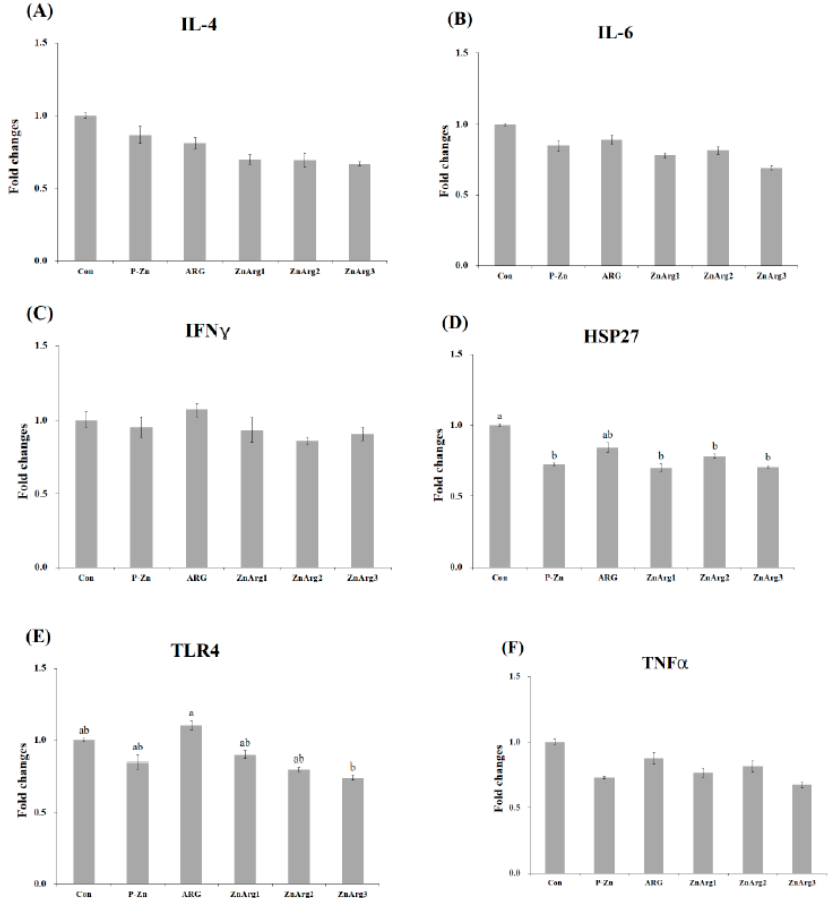
Figure 1. Relative expression of, ( A ) interleukin-4 (IL-4), ( B ) interleukin-6 (IL-6), ( C ) interferon- γ (IFN γ ), ( D ) heat shock protein-27 (HSP27), ( E ) toll like receptor-4 (TLR4), and ( F ) tumor necrosis factor- α (TNF- α ) in the liver of weanling piglets. Error bars represent standard error of means. Bars with different letters (a~b) differ significantly across all 6 treatment groups ( p < 0.05). Con: 1.1% Arg; P-ZnO: 1.1% Arg + 2500 mg Zn/kg diet; ARG: 1.6% Arg; ZnArg1: 1.6% Arg + 500 mg Zn/kg diet; ZnArg2: 1.6% Arg + 1000 mg Zn/kg diet; ZnArg3: 1.6% Arg + 2500 mg Zn/kg diet.